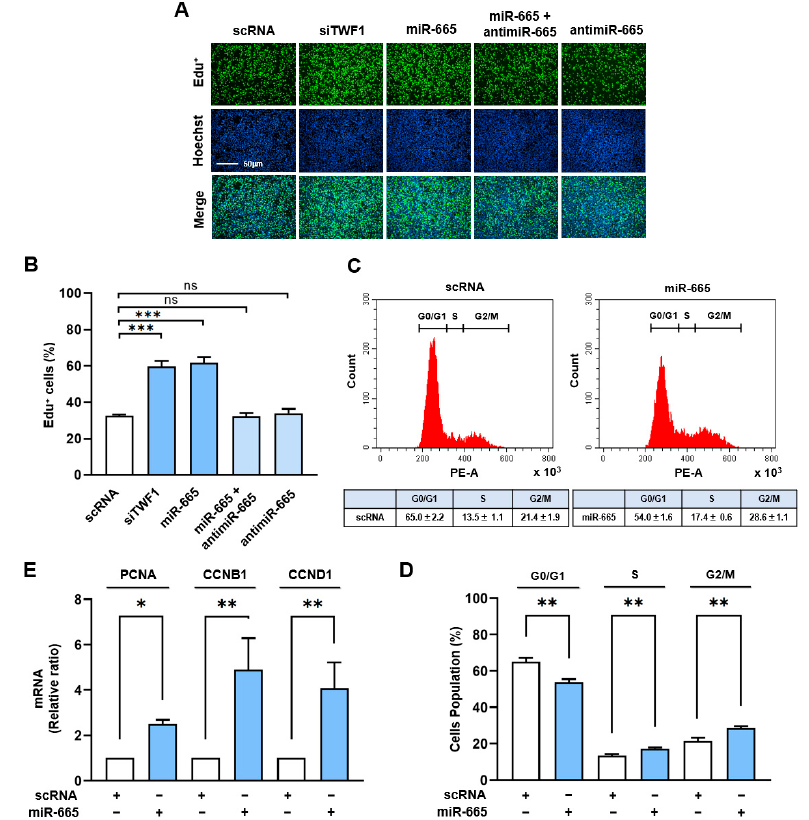
Figure 4. MiR-665-3p facilitated myoblast proliferation. C2C12 cells were transfected with miR-665 mimic, antimiR-665, siTWF1, or scRNA (200 nM) for 24 h. ( A ) Cell proliferation was analyzed using an EdU assay. Cells exhibiting DNA replication were labeled with EdU (green) and nuclei with Hoechst 33,342 (blue). Scale bar: 50 µ m. ( B ) Proportions of EdU-positive cells were determined using ImageJ software. ( C , D ) Cell cycle analysis and percentages of myoblast cells in each cell cycle phase were determined 24 after transfection. ( E ) mRNA levels of CCNB1, PCNA, and CCND1 were determined using RT- q PCR after normalization versus U6 levels. Results are expressed as the means ± SEMs of intensity ratios versus scRNA controls ( n = 3; * p < 0.05; ** p < 0.01; *** p < 0.001 vs. scRNA). ns: no